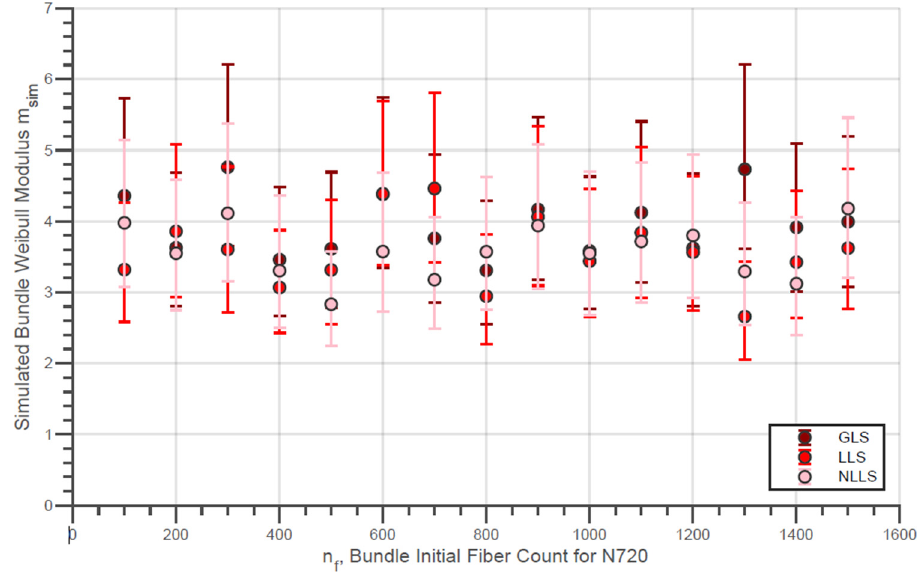
Figure 14. Simulated Weibull modulus for the true strength of fiber bundles of N720 fibers with different load-sharing models.